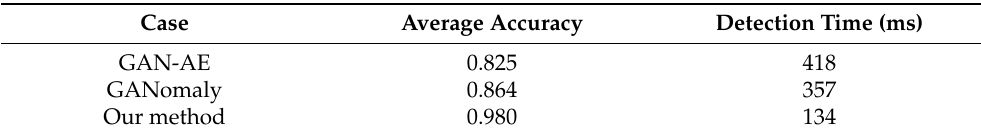
Table 8. Comparison of the average accuracy and detection time of the three methods when using current data samples